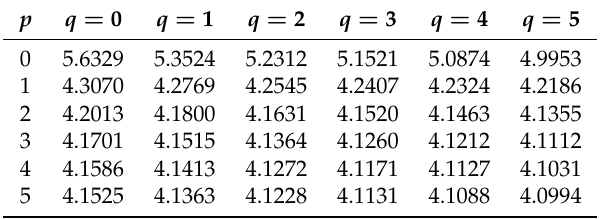
Table A8. Bit rates (bits/pixels), obtained for various values of p and q , on